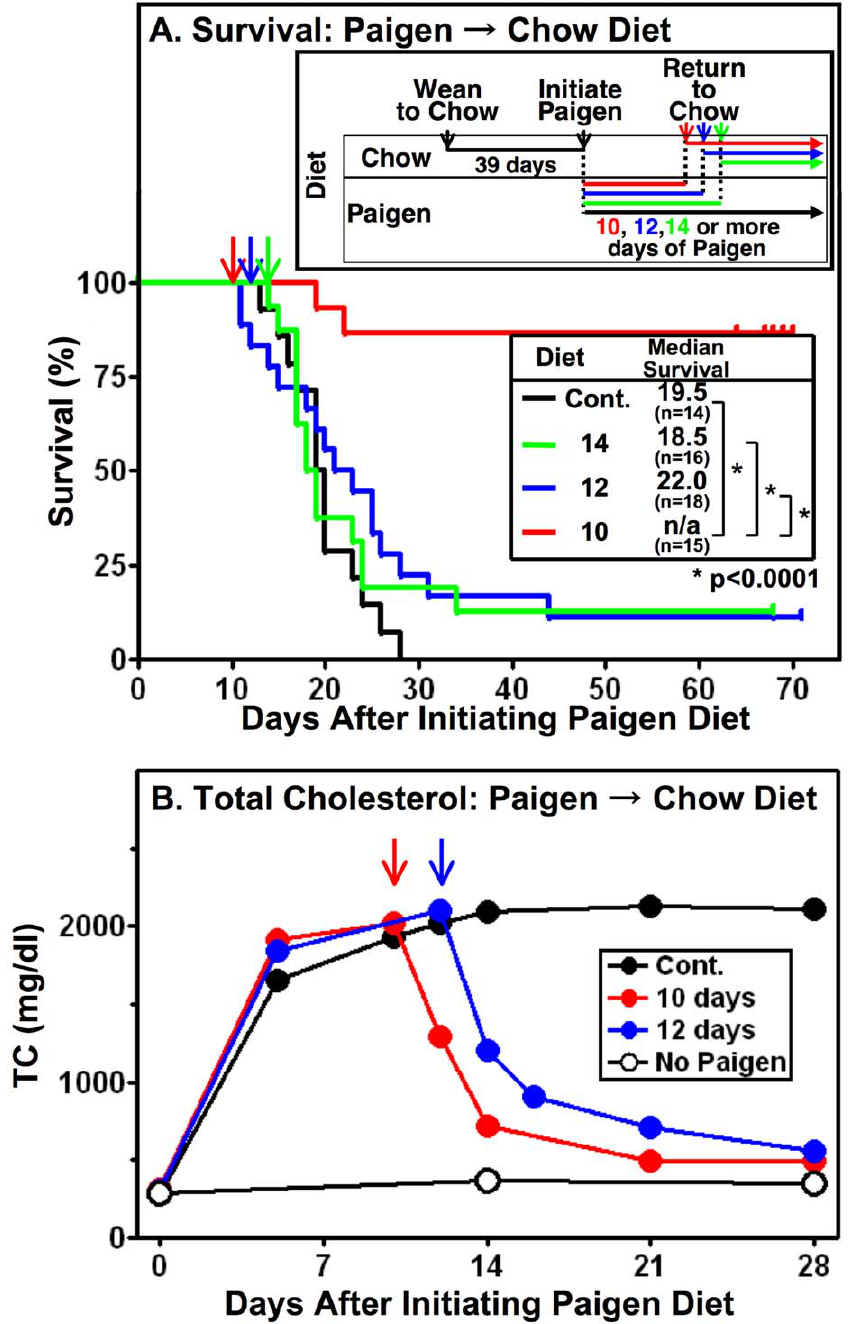
Figure 7. Effects of shifting from Paigen to chow diet on survival (A) and plasma cholesterol (B). HypoE mice were fed a normal chow diet) from weaning to 2 months of age (39 days). Beginning at two months of age the mice were housed singly (1/cage, both males and females were included) and some of the animals were continued to be fed the chow diet (panel B, white circles) whereas all of the others where switched from a normal chow diet to the Paigen diet (initiation of Paigen diet). The animals were maintained continuously throughout the rest of the experiment on the Paigen diet (‘‘Cont.’’, black lines) or after the indicated periods of Paigen diet feeding (10 days, red; 12 days, blue; 14 days, green) the mice were returned to a chow diet for the remainder of the experiment (colored arrows), as indicated in the schematic inset in panel A. A Kaplan-Meier survival curves. Log-rank test was performed to compare survival curves. B Time course of changes in plasma total cholesterol levels. Blood samples were taken serially at the indicated times (see Methods) from subgroups of animals different from those used for the survival curves in panel A (Cont.;n=9, 10 days; n=6, 12 days; n=9, No Paigen(chow); n=6). The data are presented as mean values of TC in each subgroup at the indicated times. In those cases in which animals died during the period of serial sampling, the data obtained from those mice while alive were incorporated into the calculation of the mean values.